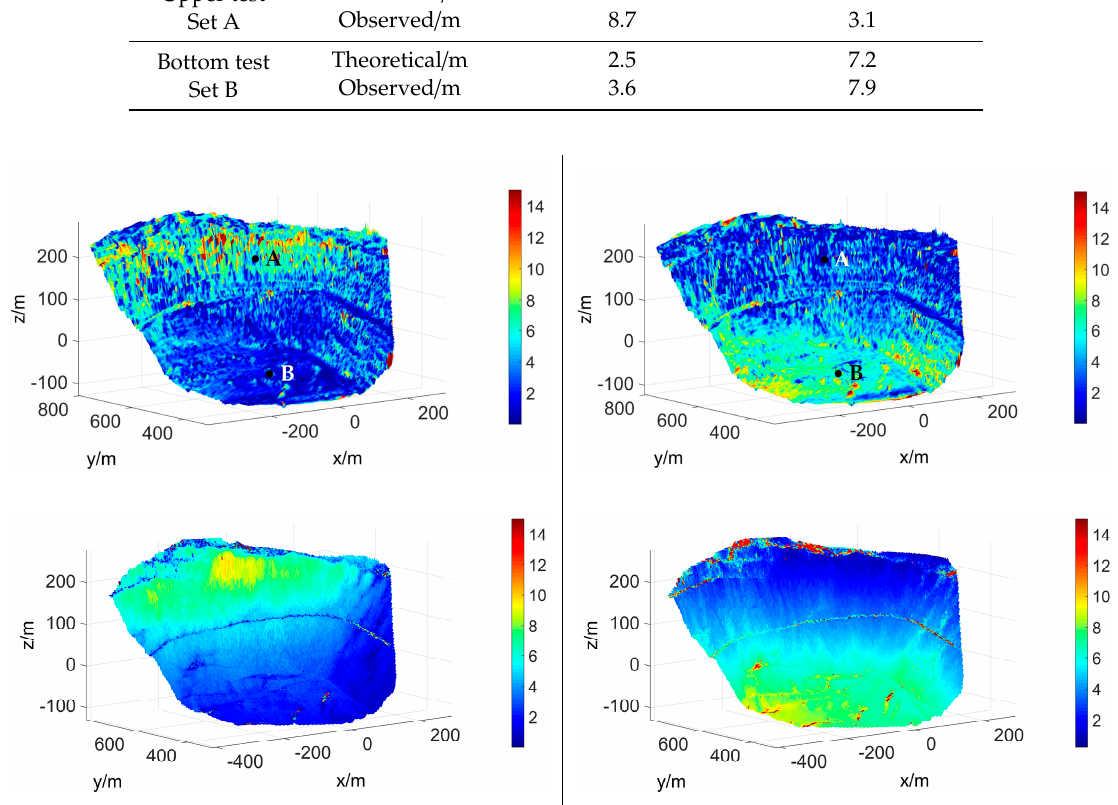
Figure 15. DEM error distributions with different main error source situations.